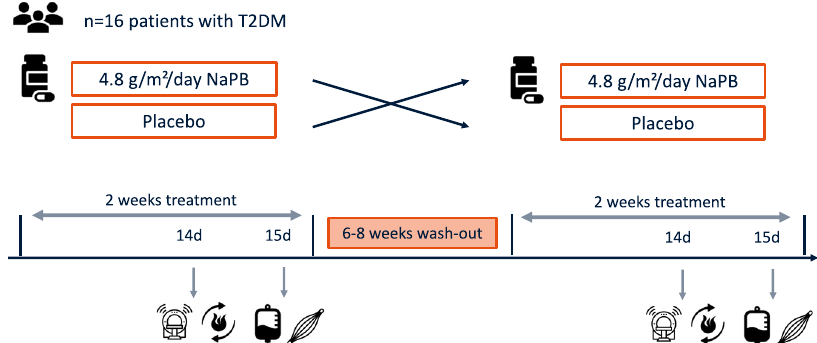
Fig. 1 Experimental design. In this crossover study, participants were randomly assigned to start with 2-week NaPB supplementation or placebo treatment.